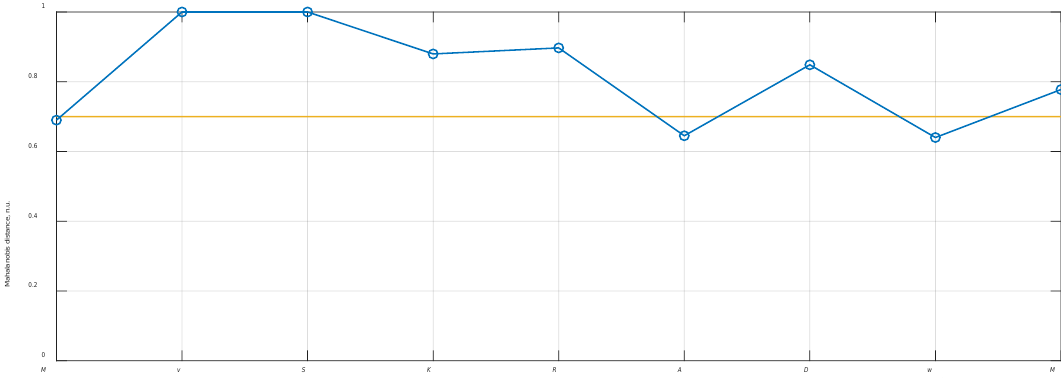
Figure 3. The normalized Mahalanobis distance between different statistical features of the discharge and random noise vectors (in blue) and the threshold level of 0.7 (orange) which was used to select the significant features.